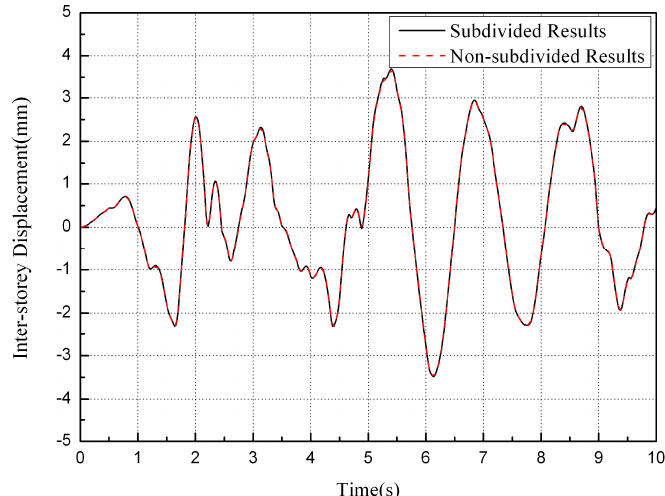
Figure 10. Time history curve of the story drift with different integral steps.